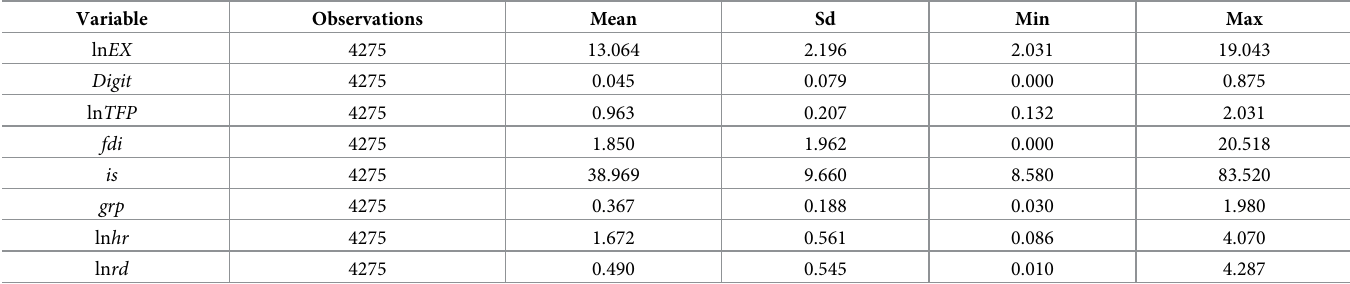
Table 1. Summary statistics for